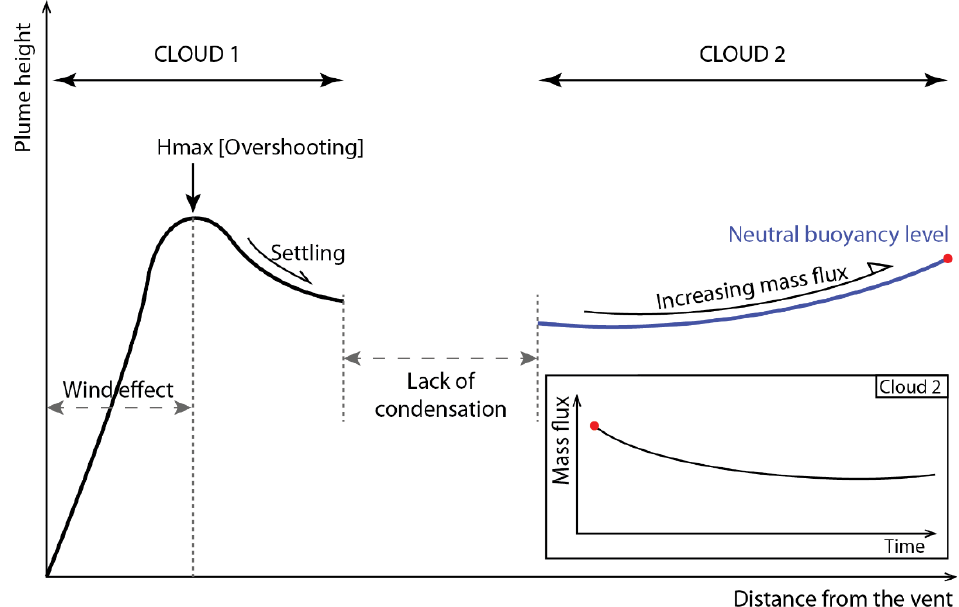
Figure 12. Summary of the dispersion dynamics of the 26 October 2013 Etna fountain-fed plume and cloud system. The red dot indicates the visible end of cloud 2 at the image edge.